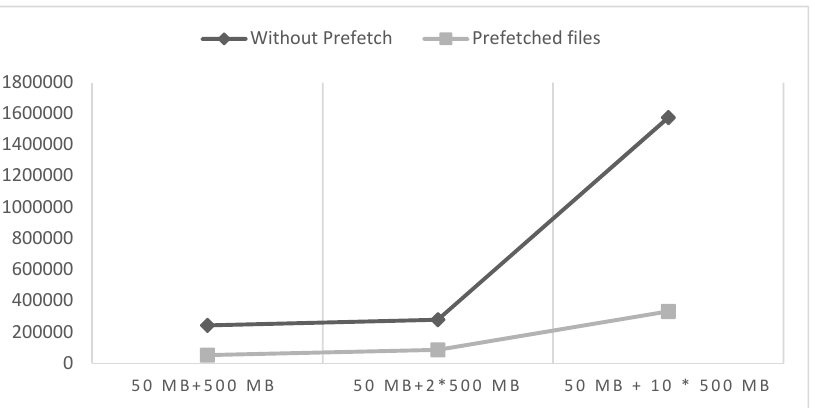
Figure 13. Average download times of different encrypted health records while performing simul- taneous requests asking for different files to the deployed to the storage cloud and deployed in different data centers.